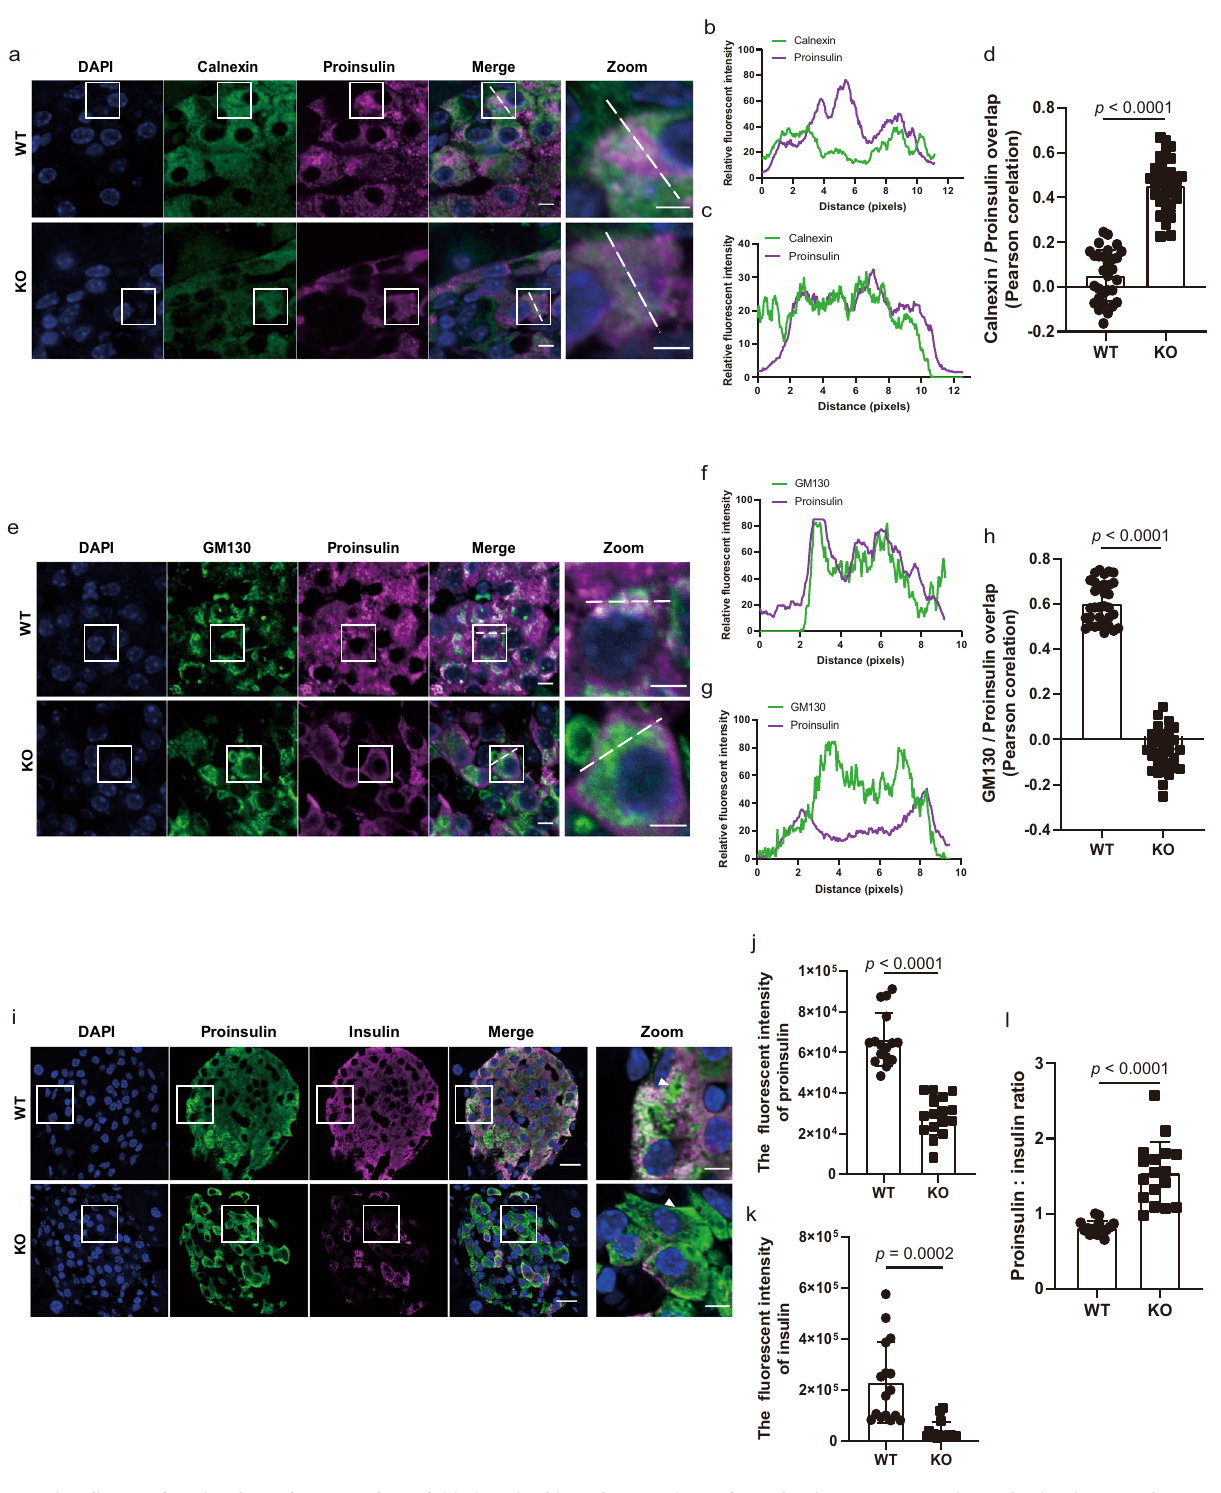
Fig. 2 Proinsulin translocation from the ER to the Golgi is impaired in Wfs1 KO mice. a – h Confocal microscopy analysis of colocalization of proinsulin with calnexin (ER marker, a – d ) or GM130 (Golgi marker, e – h ) in pancreatic sections of the WT and Wfs1 KO mice. Trace outline is used for line-scan (white dashed line) analysis of the relative fl uorescence intensity of proinsulin with calnexin or GM130 signals. Signal overlap was quanti fi ed by Pearson correlation analysis. n = 3 independent experiments, n = 30 independent images quanti fi ed. Scale bar, 5 μ m. Scale bar for zoom fi gures, 3 μ m. i Confocal microscopy of proinsulin and insulin in pancreatic sections of the WT and Wfs1 KO mice. Pancreatic sections were immunostained with anti-proinsulin and anti-insulin primary antibodies, followed by Alexa Fluor-conjugated secondary antibodies. Scale bar, 10 μ m. Scale bar for zoom fi gures, 5 μ m. j – k , The fl uorescence intensities of proinsulin ( j ) and insulin ( k ) were quanti fi ed by the ImageJ software. l The ratio of fl uorescence intensity of proinsulin to insulin. n = 3 independent experiments, n = 16 independent images quanti fi ed. All the data are presented as mean ± s.e.m. p < 0.05, signi fi cant, using a two-tailed Student ’ s t -test. Source data are provided as a Source Data fi